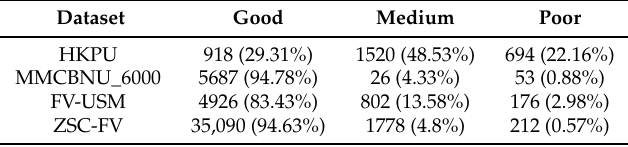
Table 2. Statistics of the number of image samples with different qualities for the four datasets.